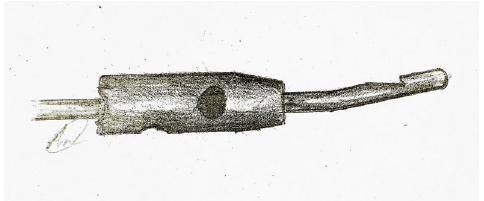
Figure 12. Self ‐ manufactured V ‐ shaped groove hook. Figure 12. Self-manufactured V-shaped groove